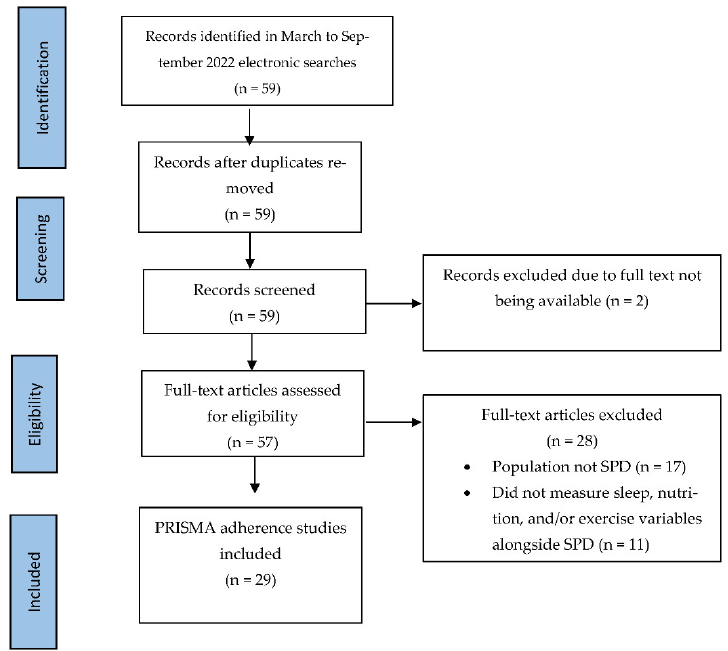
Figure 1. Flowchart of literature search of the number of studies on schizotypy and sleep, nutrition, and physical exercise following the PRISMA-SCR guidelines.